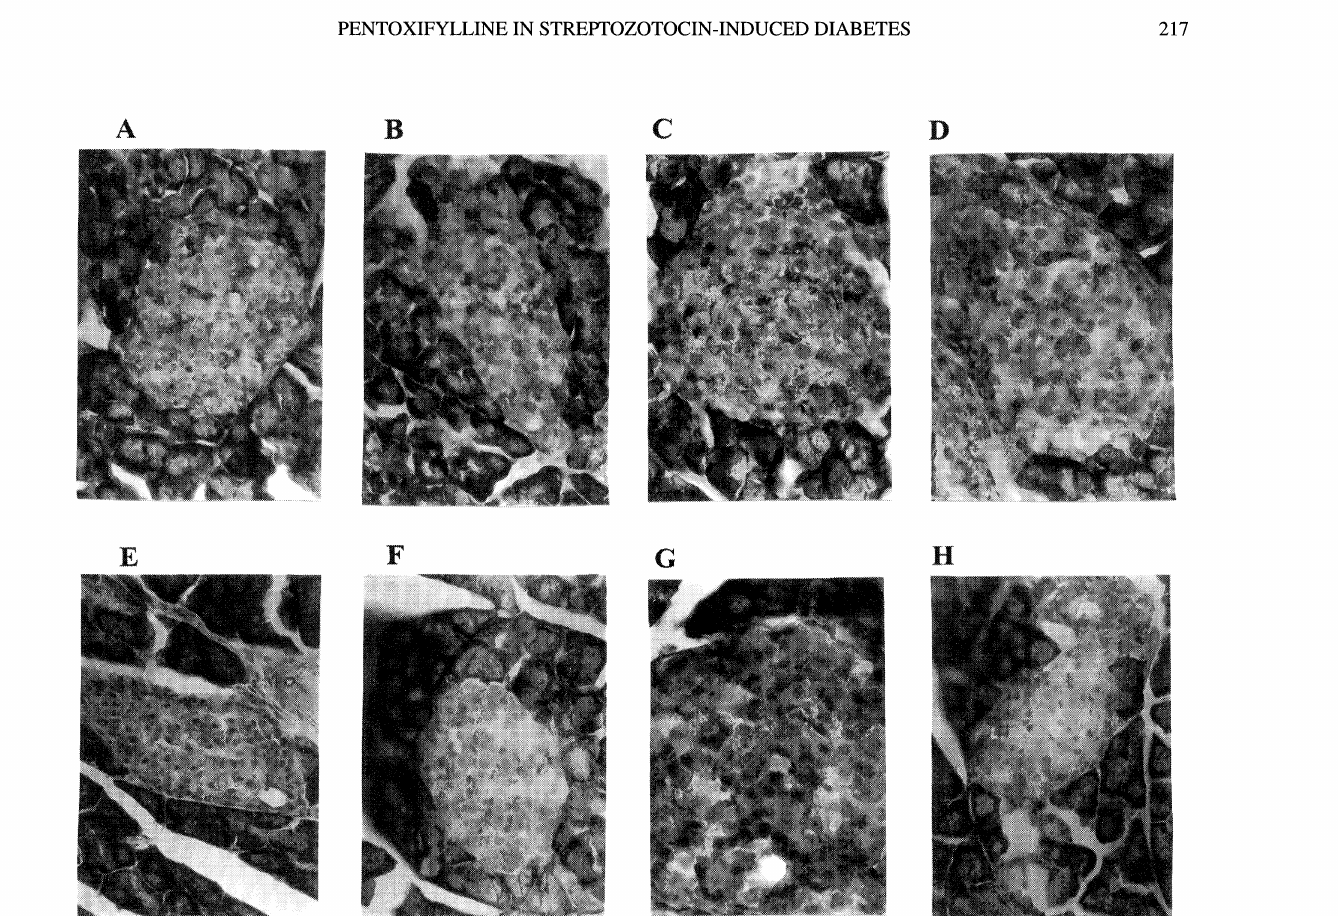
FIGURE 3 Effects of PTX treatment on the MLD-SZ-induced cellular changes in rat pancreas on day 10, as revealed by immunohistochemi- cal staining (PAP). Upper panels, Control DA rats treated with MLD-SZ only. Note diffuse infiltration of mononuclear cells and the initial necrotic changes. Lower panels, DA rats treated with MLD-SZ + PTX. Note the absence of intrainsulitis with low degree of islet cell destruc- tion. CD4 cells (W3/25 mAb), (A) mag. 120 and (E) mag. 120; CD8 cells (OX8 mAb), (B) mag. 120 and (F) mag. 120; ED1 blood-born macrophages (ED1 mAb), (C) mag. 180 and (G) mag. 180; MHC Class II cells (OX6 mAb), (D)